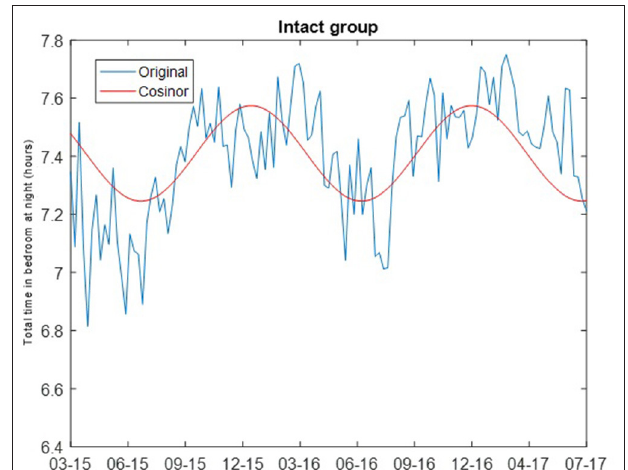
FIGURE 1 | Cosinor fits of total time in bedroom at night of cognitively intact group. Cosinor fit for the cognitively intact group which shows a stronger relationship between total time in bedroom at night and day of